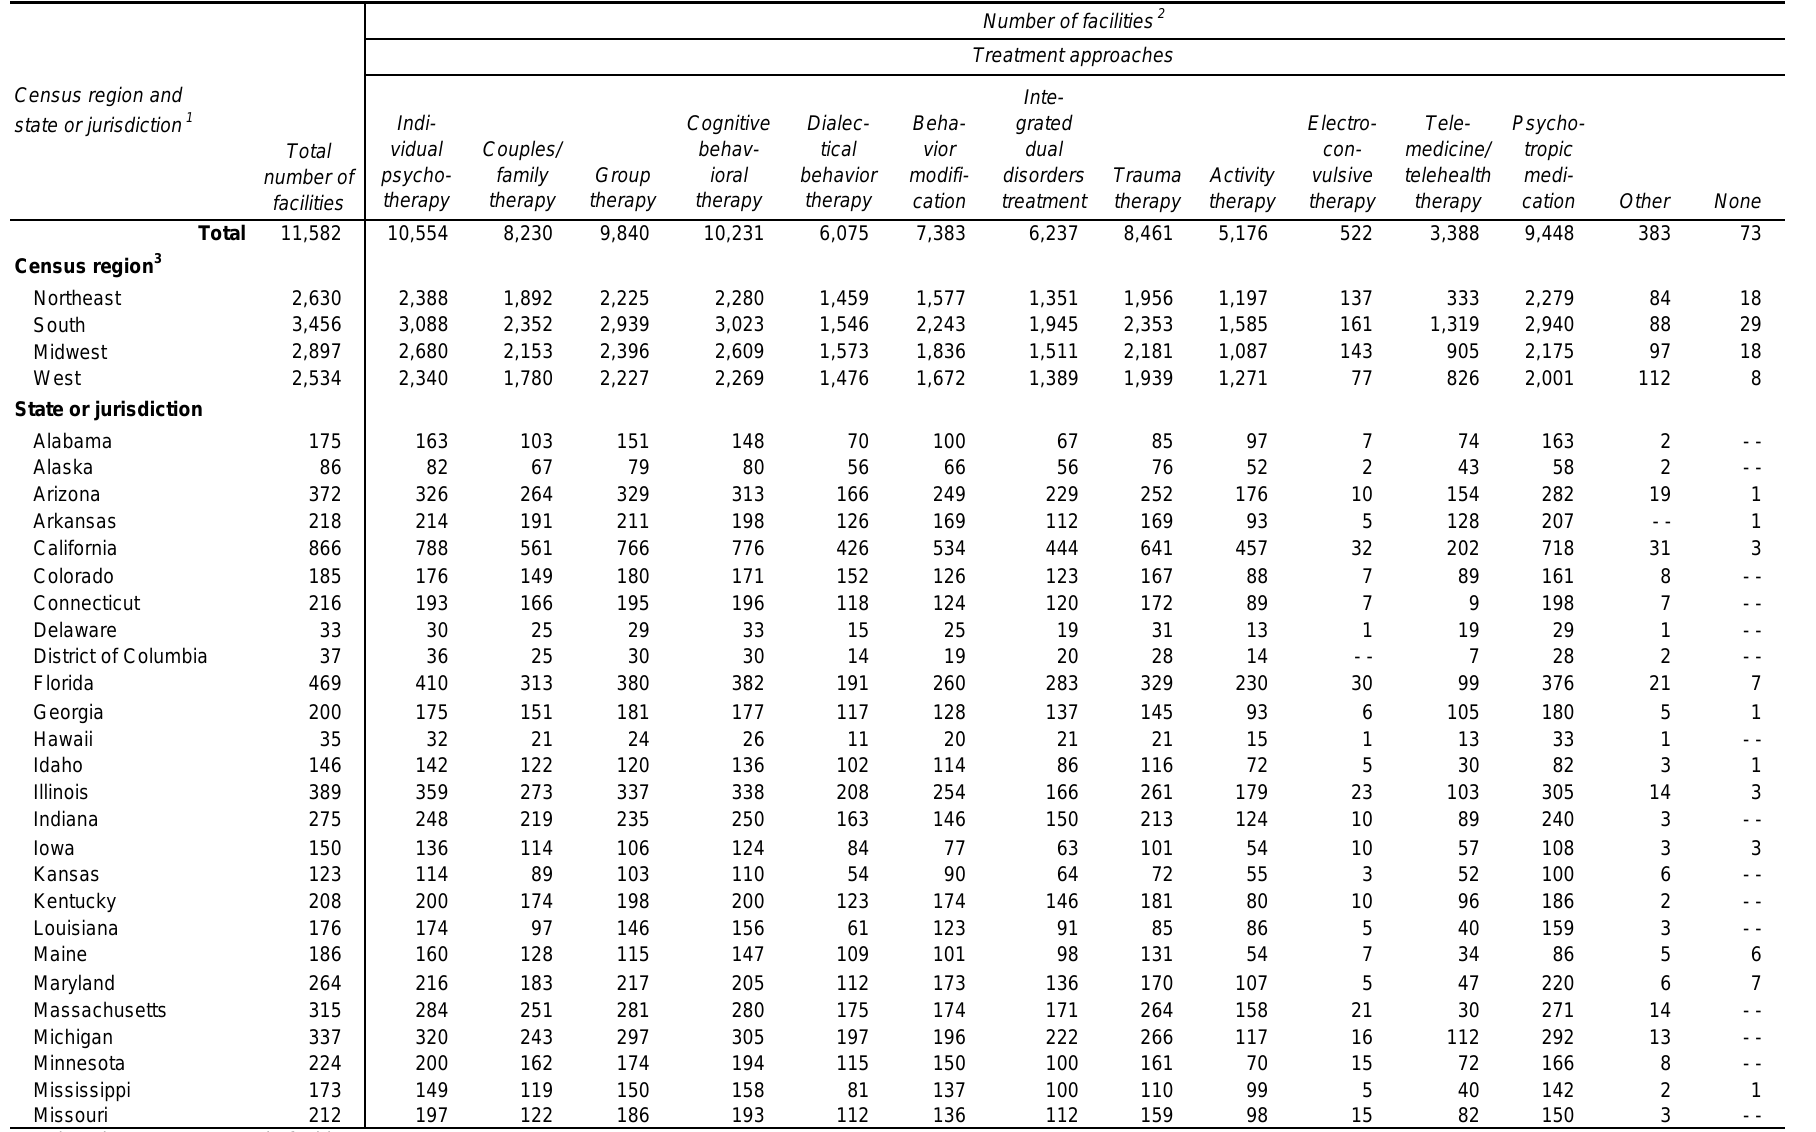
Table 3.7a. Treatment approaches offered, by Census region and state or jurisdiction: Number,